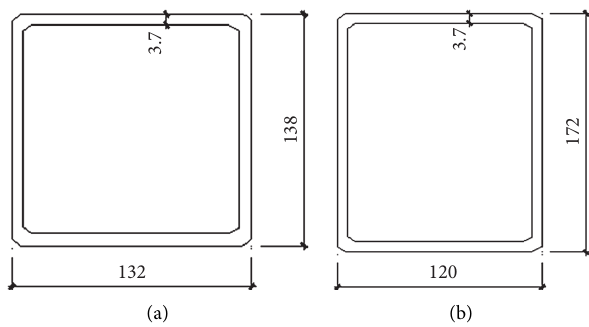
Figure 8: Section making of square steel: (a) ZF series and (b) CF series.